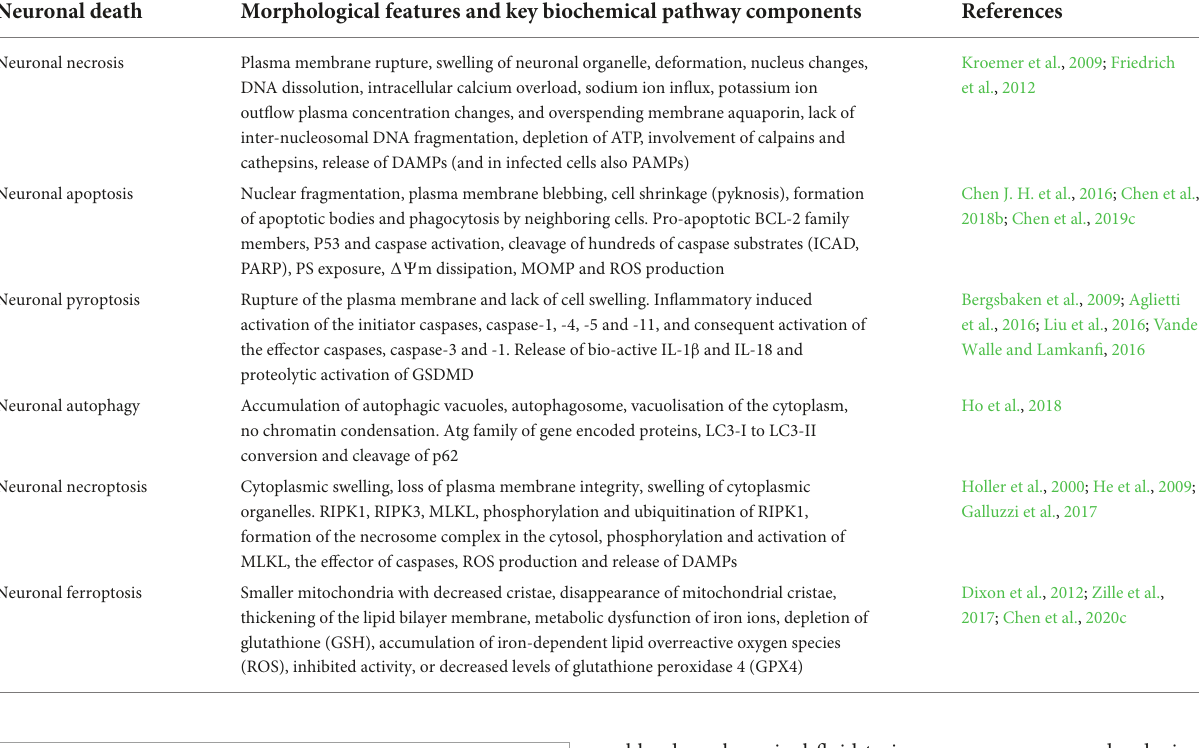
TABLE 1 Neuronal death pathways and associated morphological and biochemical hallmark features.